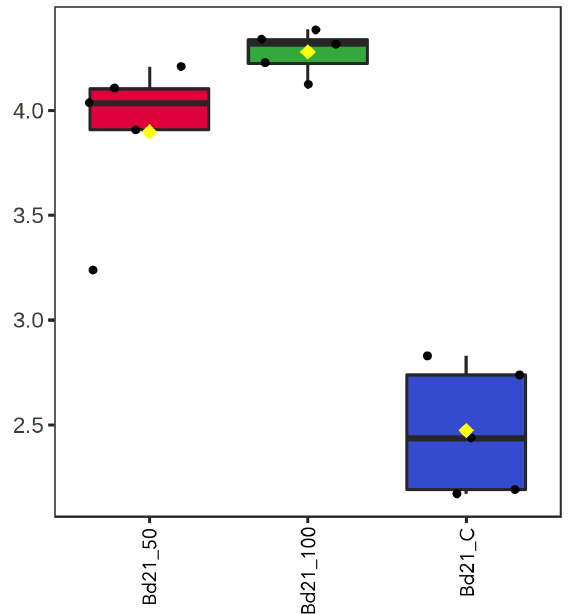
Figure 11. Box and whisker plot of the relative glutathione levels within the Brachypodium Bd21 samples under salt stress conditions. Labels on the x -axis refer to the NaCl concentrations (50 mM, 100 mM and the control, respectively). The y -axis represents the glutathione content as a % of the total ion count in a given sample. Black dots represent repetitions and yellow diamonds indicate the mean values.